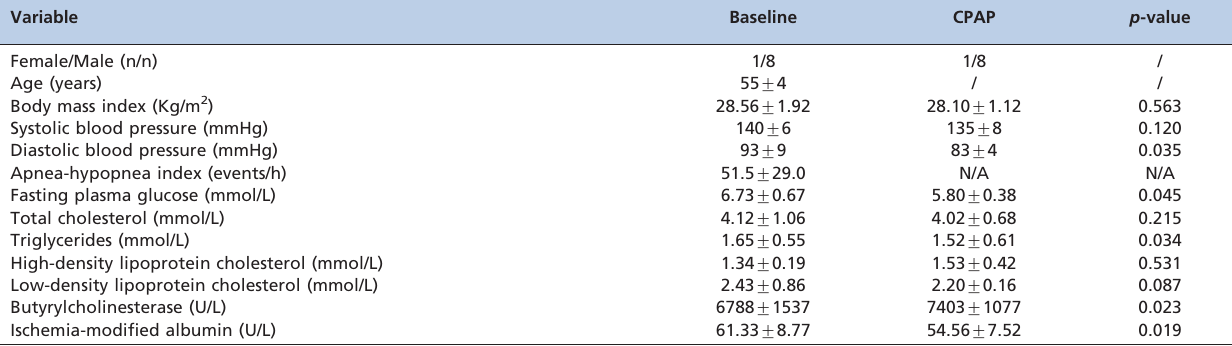
Table 3 - Demographic information and laboratory values for obstructive sleep apnea patients at baseline and after nasal continuous positive airway pressure treatment (n= 9).